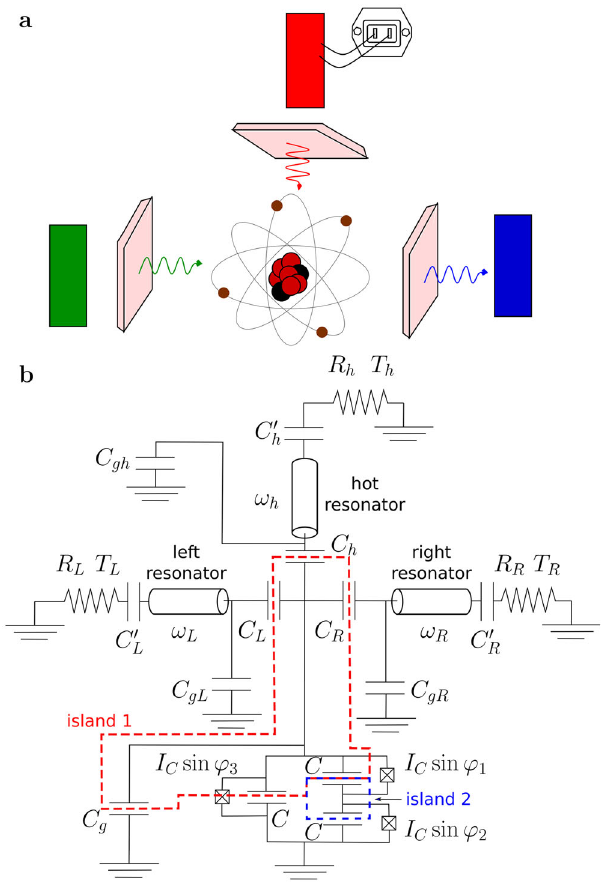
Fig. 1 Three terminal device with circuit schematic used for simulations. a Heat transport in a three terminal system containing an arti fi cial